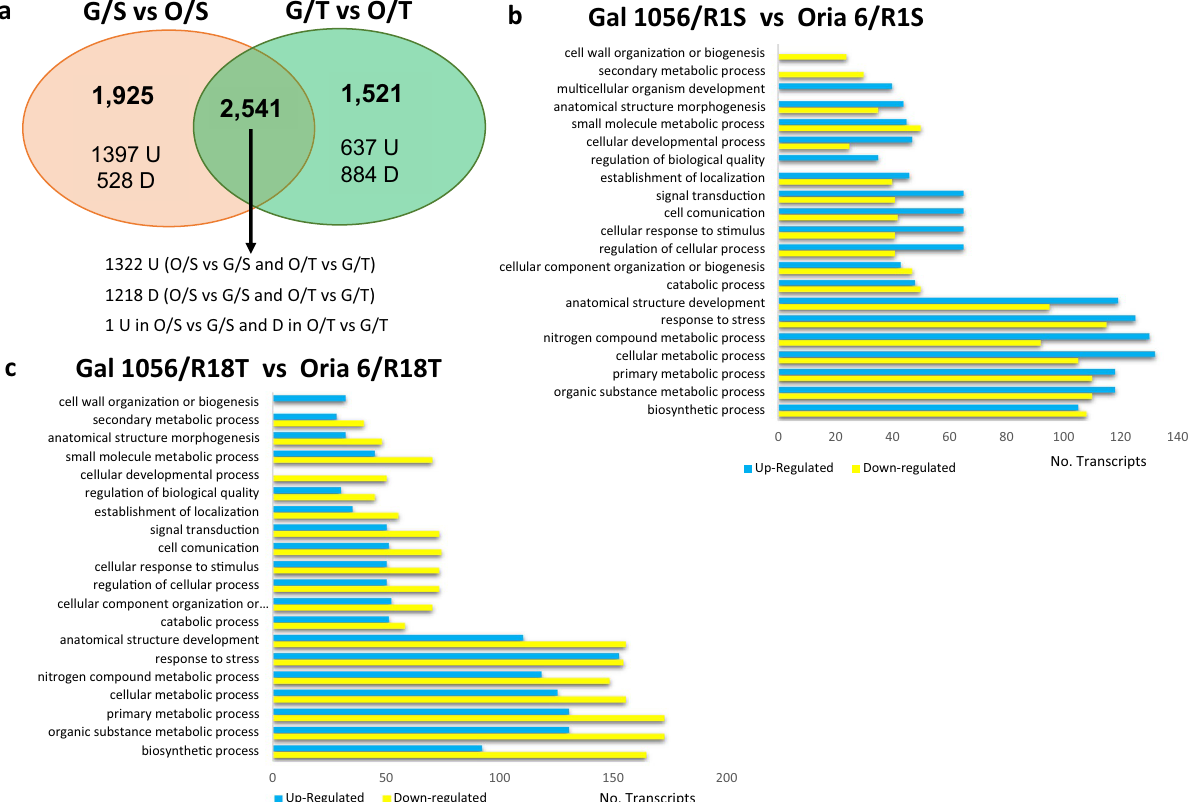
Figure 5. DEGs identified in needles of drought-sensitive (G: Gal1056) versus drought-tolerant (O: Oria6) scions grafted onto drought-sensitive (S: R1S) or drought-tolerant (T: R18T) rootstocks. ( a ) Venn diagram showing DEGs [Log2FC ≤ − 1.5 and Log2FC ≥ 1.5] for upregulated (U) and downregulated genes (D), respectively. ( b – c ) Histogram presentation of GO terms enriched in significantly upregulated (blue) and downregulated (yellow) genes exclusively differentially expressed in G/S versus O/S ( b ) and G/T versus O/T ( c ) scions. P values ( P < 0.05) were calculated according to the Wald